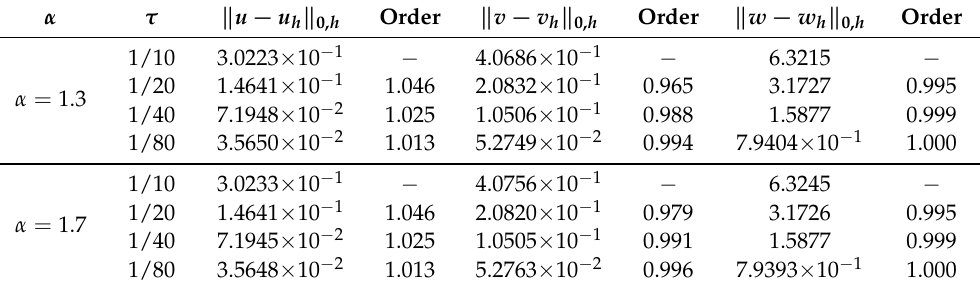
Table 1. L 2 -norm errors and temporal convergence order of MFVE method.